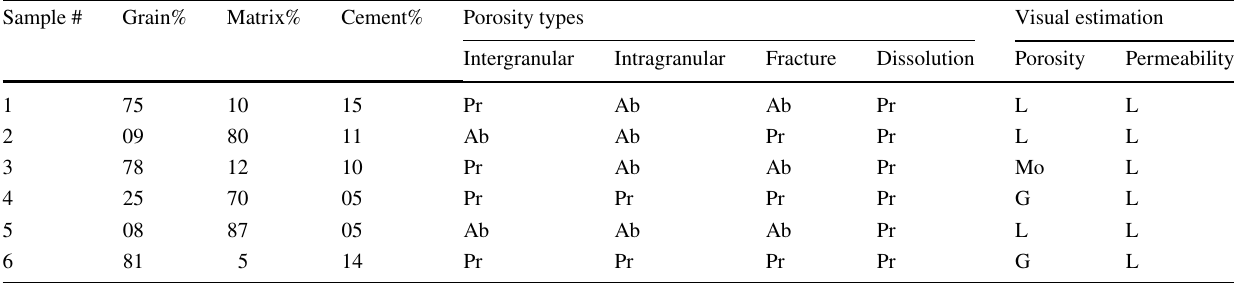
Table 2 Petrographic analysis of the Jurassic Shinawari Formation